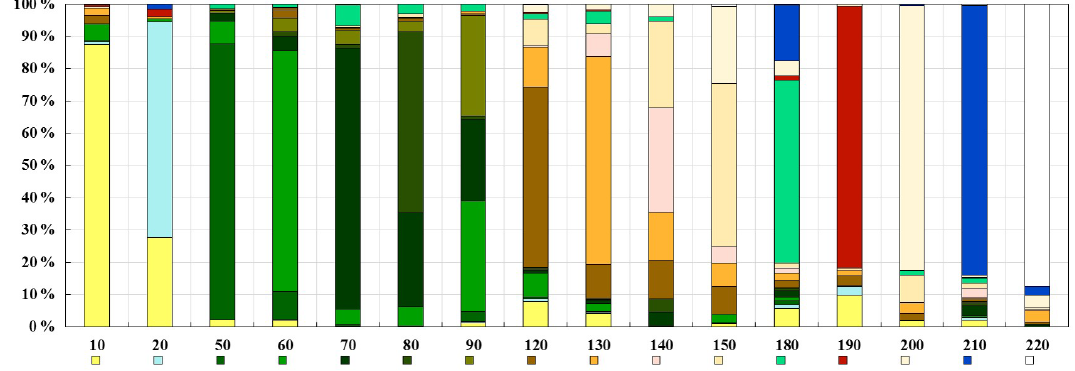
Figure 6. The confusion proportions for each of the land-cover types in the LCCS level-1 validation